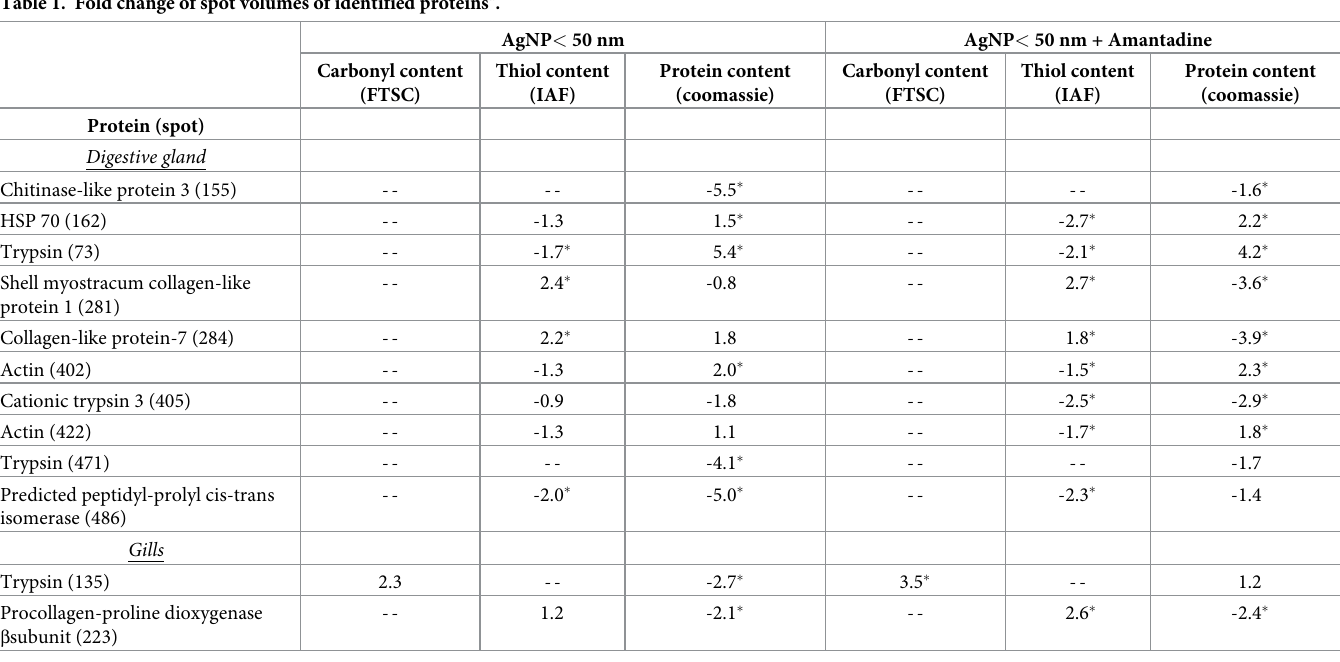
Fig 1. Representative 2DE separation of digestive gland proteins. Spots selected for excision and identification by MALDI TOF-MS/MS are among the numbered ones. https://doi.org/10.1371/journal.pone.0205765.g001 Table 1. Fold change of spot volumes of identified proteins a